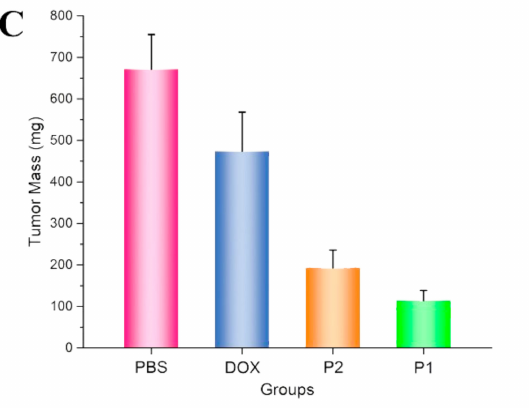
Figure 8. ( A ) Changes in tumor volume after intravenous injection of P1, P2, DOX, and PBS (Small arrows refer to the time of administration in mice). ( B ) The changes of body weight. ( C ) Final tumor weights.